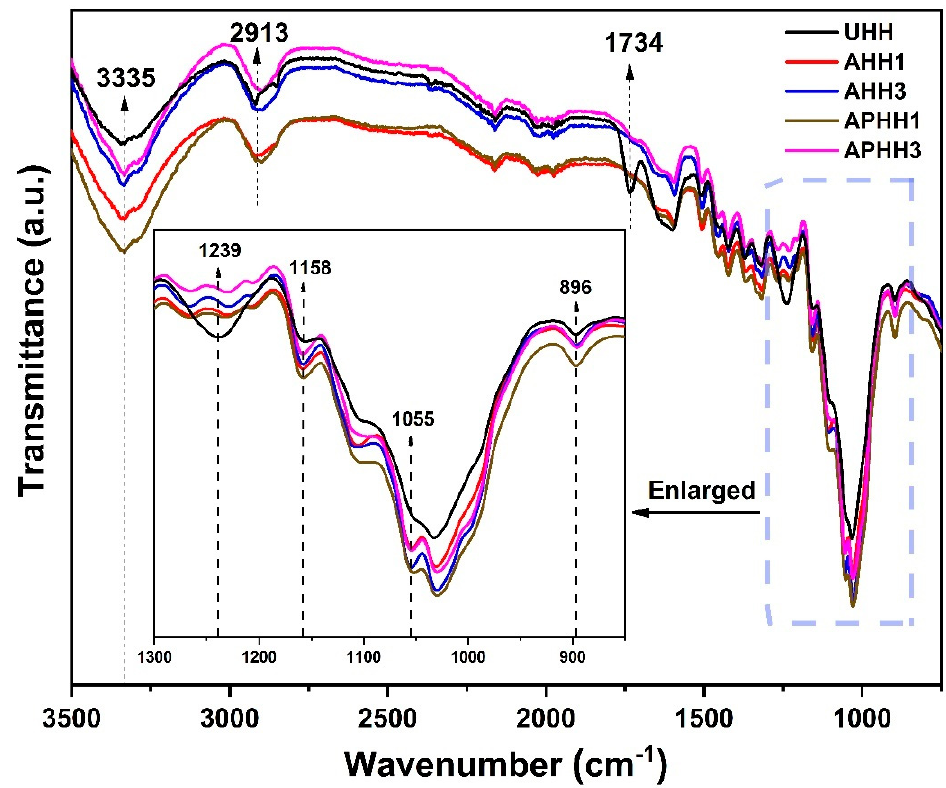
Figure 1. FTIR spectra of untreated and treated hemp hurd powders.